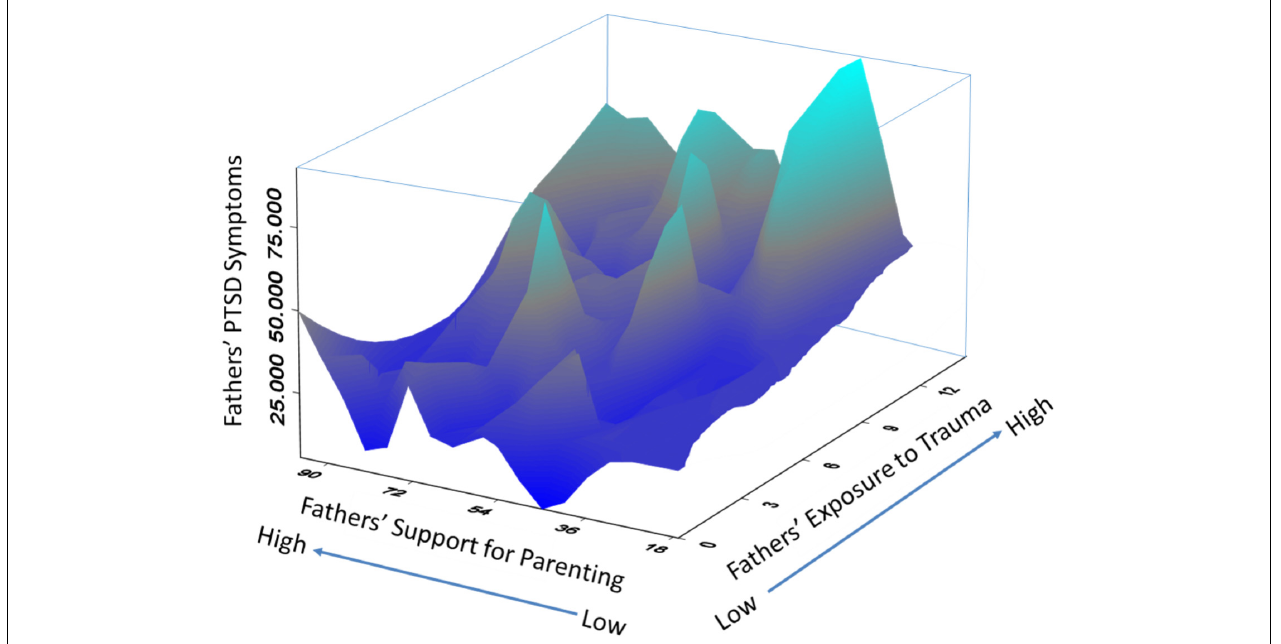
FIGURE 8 | 3D surface plot of observed data for fathers in military families. Y-axis is the 2-year average PTSD symptoms, the X-axis is fathers’ exposure to military trauma, and the Z-axis is fathers’ social support for parenting needs. The buffering effect is of support is represented in the upper left corner and risk is represented in the upper right corner (hight trauma and low